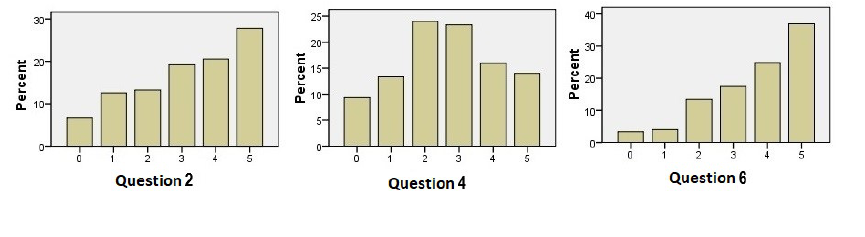
Figure 2: Equal segments